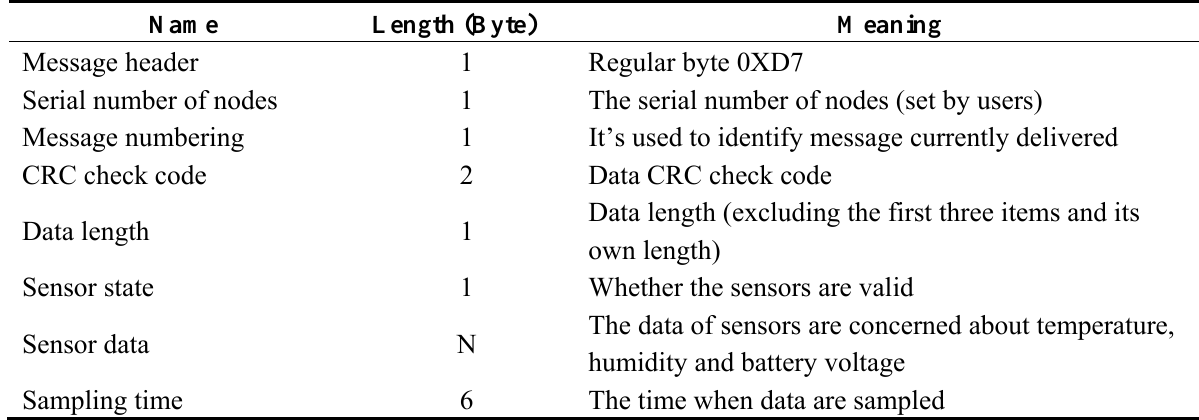
Table 1. node sent to the base station data